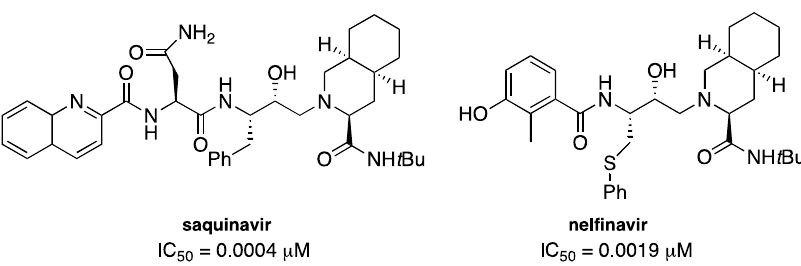
Figure 1. Structures of saquinavir and